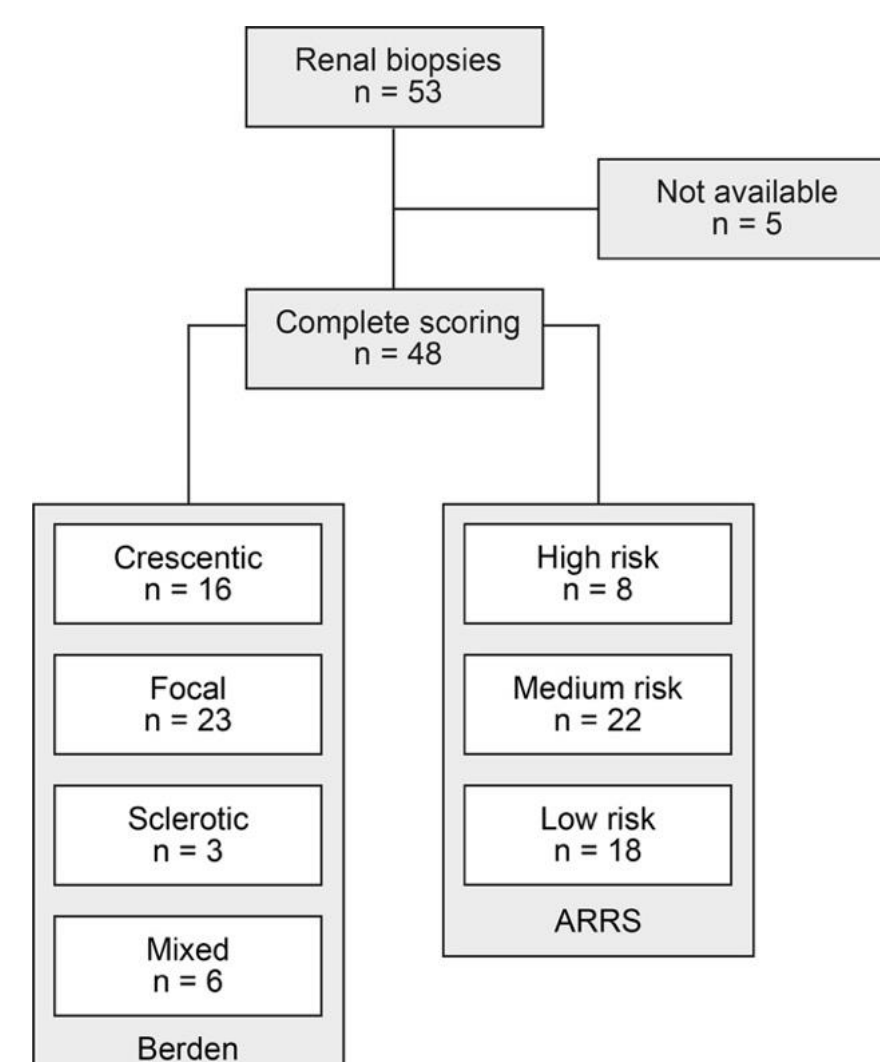
Figure 1. Total patient cohort of ANCA GN: STROBE flow chart of patient disposition with systematic histological scoring of tubular injury lesions. Abbreviations: ANCA, anti-neutrophil cytoplasmic antibodies; ARRS, ANCA renal risk score; GN, glomerulonephritis; STROBE, Strengthening the Reporting of Observational Studies in Epidemiology.